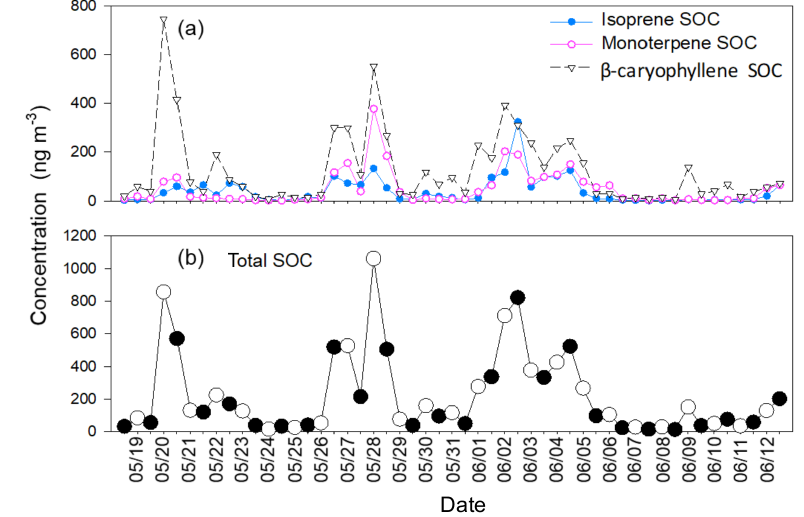
Figure 8. Temporal variations in (a) secondary organic carbon (SOC) derived from isoprene, α / β -pinene, and sesquiterpene and (b) the total SOC levels in the marine aerosols over the East China Sea during May to June 2014. The open and shaded circles represent the daytime and nighttime samples, respectively.